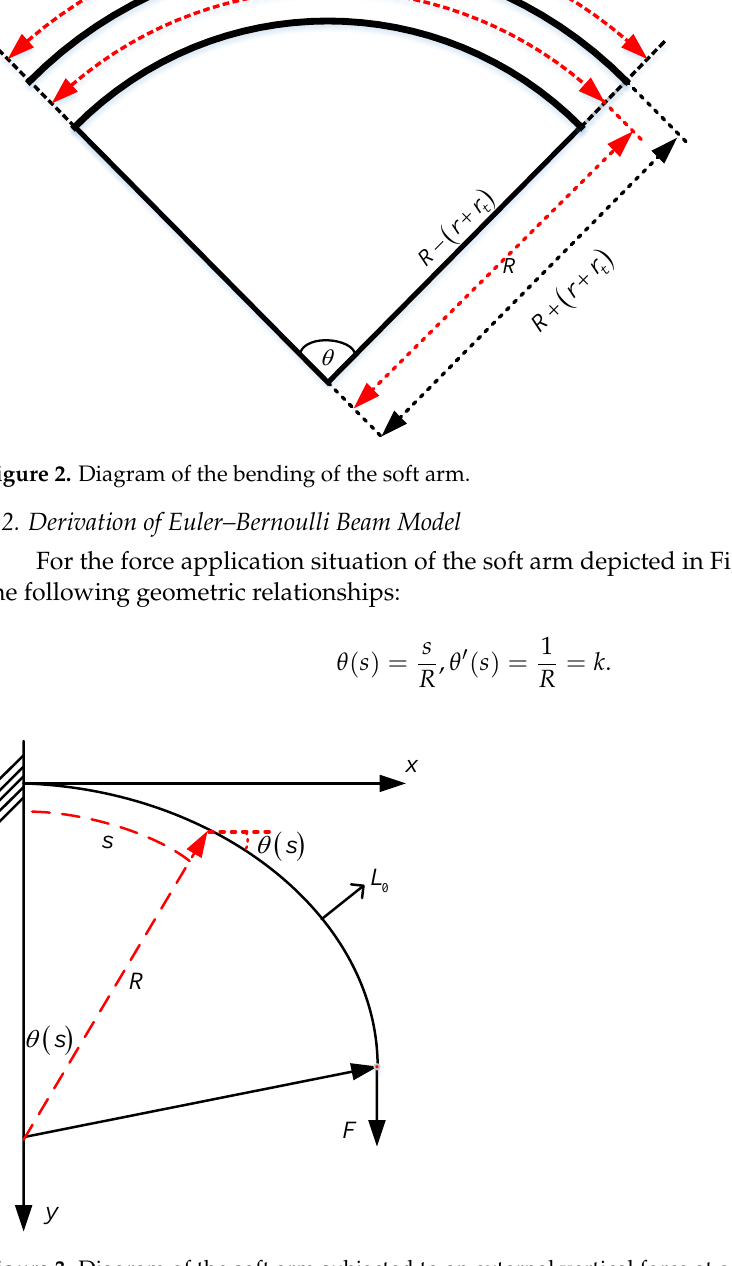
Figure 3. Diagram of the soft arm subjected to an external vertical force at one end.